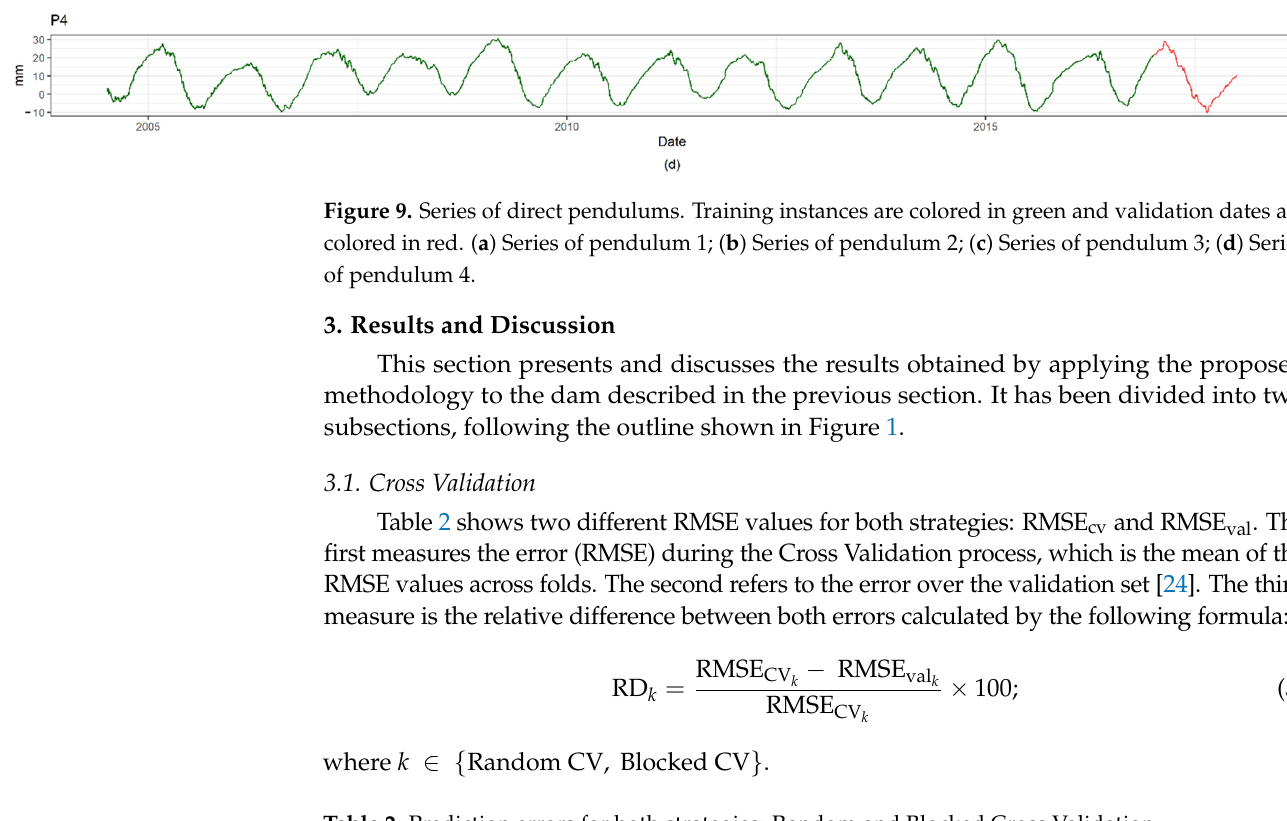
Table 2. Prediction errors for both strategies: Random and Blocked Cross